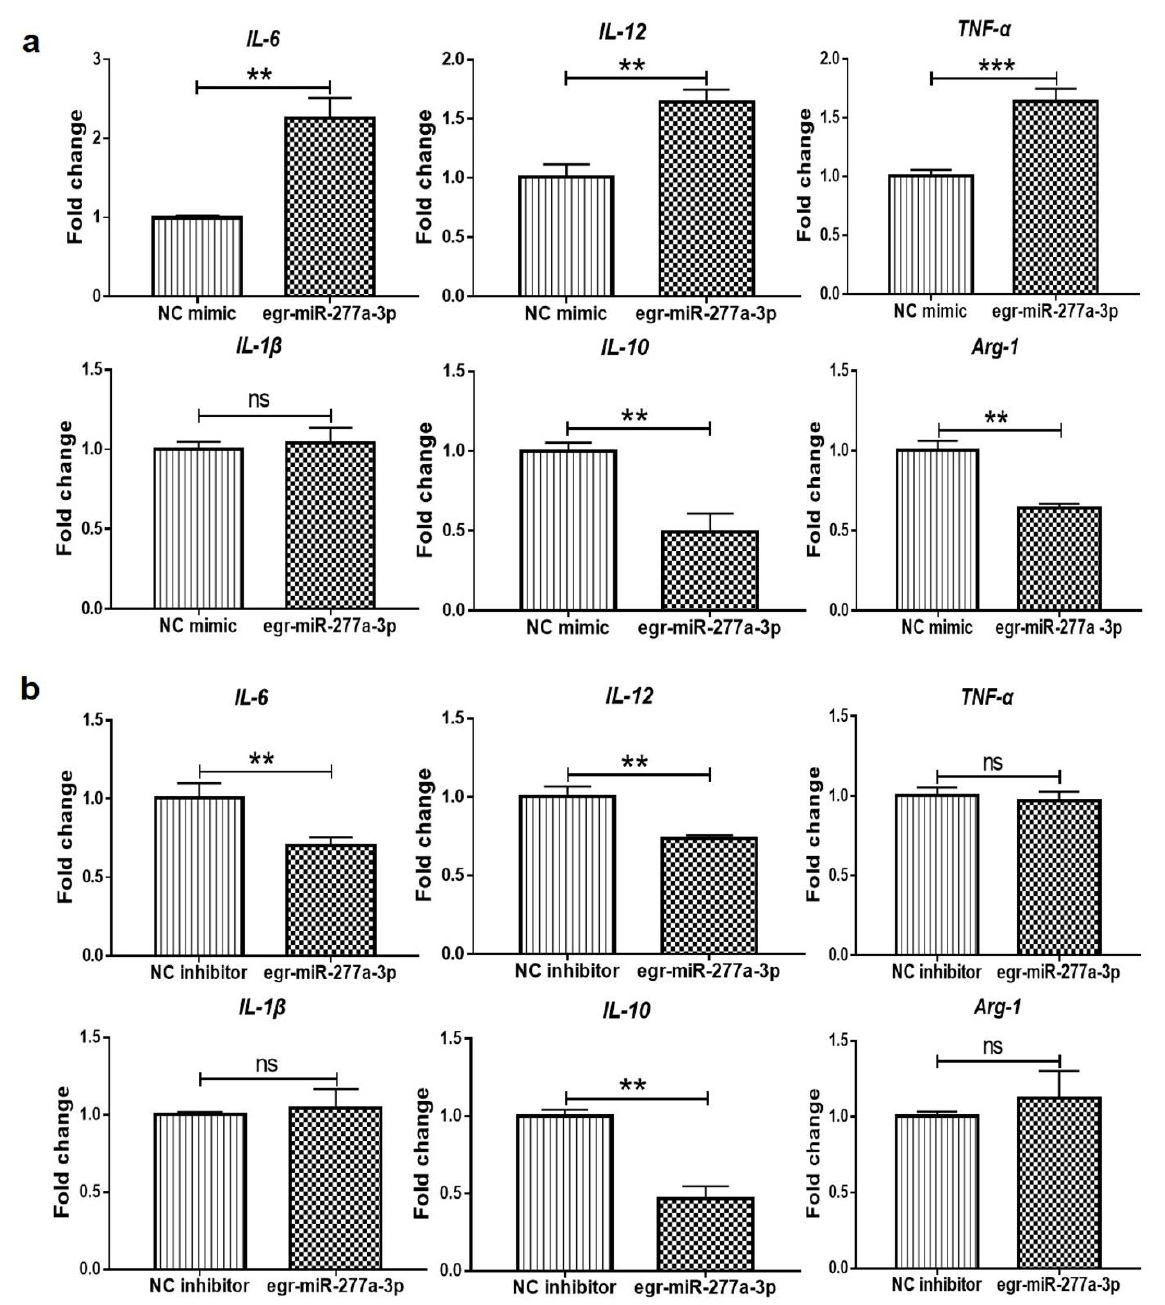
Figure 6. The mRNA levels of interleukin ( IL ) -6 , IL-12 , tumor necrosis factor-alpha ( TNF-a ) , IL1- β , IL-10, and arginase-1 ( Arg-1 ) in BMDCs transfected with the egr-miR-277a-3p mimic and inhibitor, as detected by qRT-PCR. ( a ) The qRT-PCR results in BMDCs transfected with the egr-miR-277a-3p mimic; ( b ) The qRT-PCR results in BMDCs transfected with the egr-miR-277a-3p inhibitor. ** p < 0.01; *** p < 0.001; ns, not significant. *** p < 0.001; ns, not